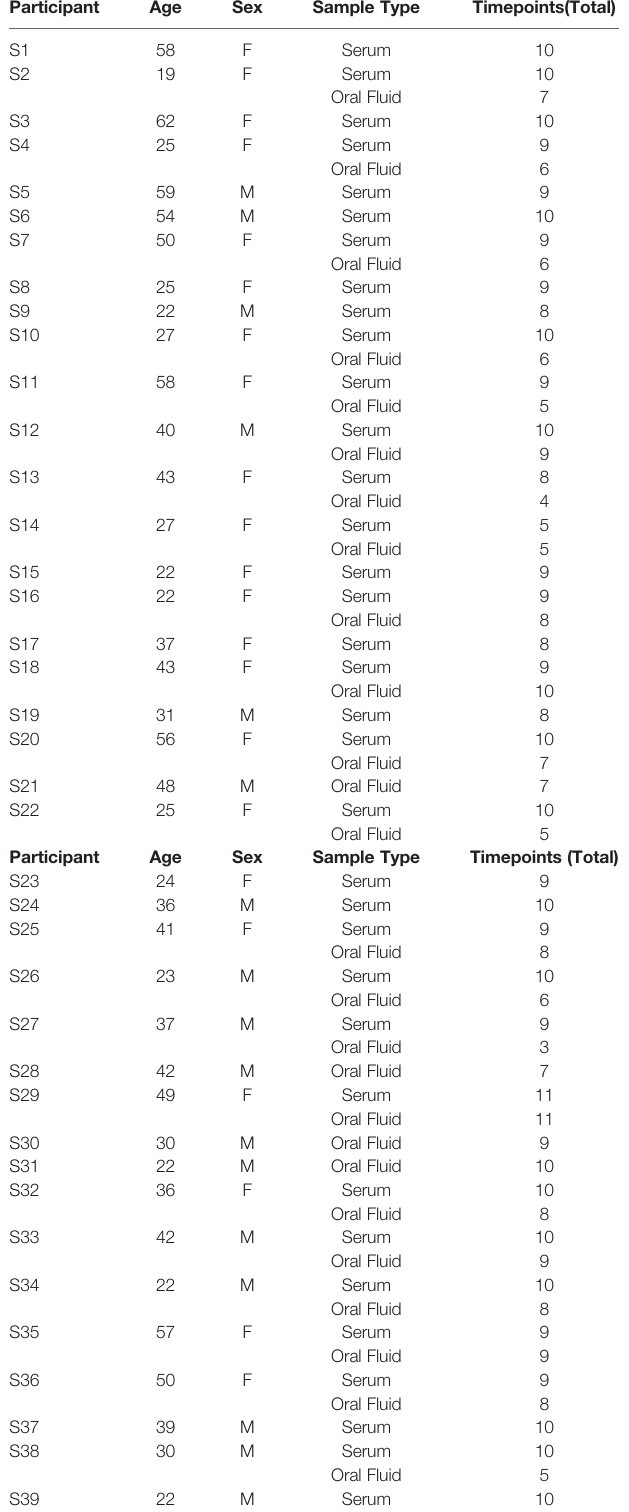
TABLE 1 | Summary of oral mucosal fl uid and serum samples collected from each participant, including their age and sex.